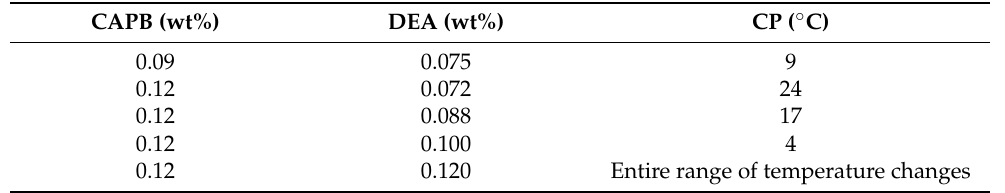
Table 2. Cloud points for CAPB/DEA